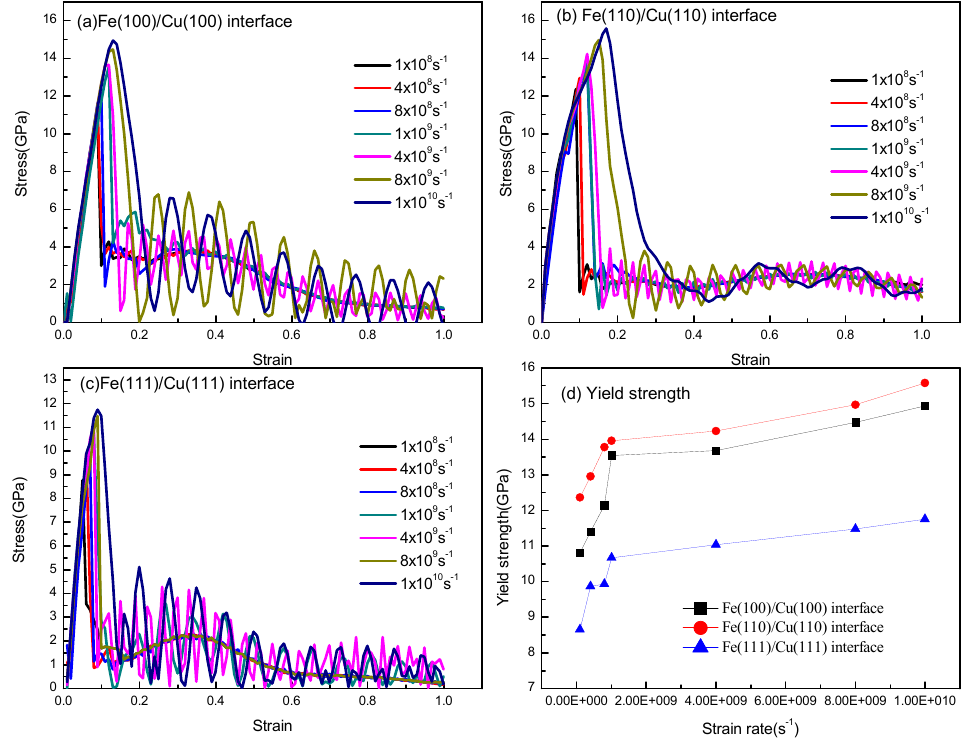
Figure 8. Stress–strain curves of ( a ) Fe (100)/Cu (100) interface at different strain rates from 1 × 10 8 /s to 1 × 10 10 /s; ( b ) Fe (110)/Cu (110) interface at different strain rates from 1 × 10 8 /s to 1 × 10 10 /s; ( c ) Fe (111)/Cu (111) interface at different strain rates from 1 × 10 8 /s to 1 × 10 10 /s; ( d ) the yield strength of three different interface models under different strain rates.